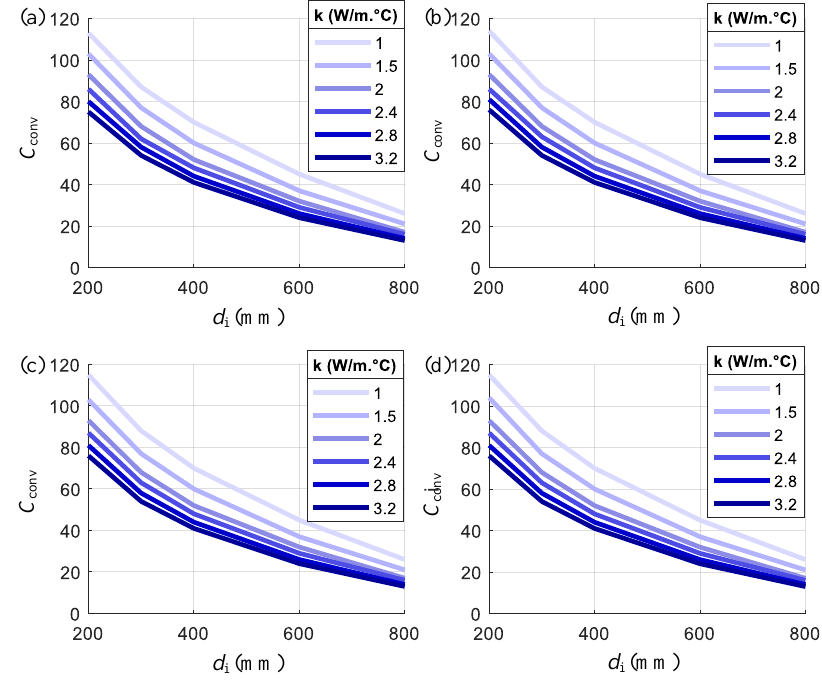
Figure 20. C conv for different c : ( a ) 830 J/kg·°C; ( b ) 890 J/kg·°C; ( c ) 940 J/kg·°C; ( d ) 1000 J/kg·°C.